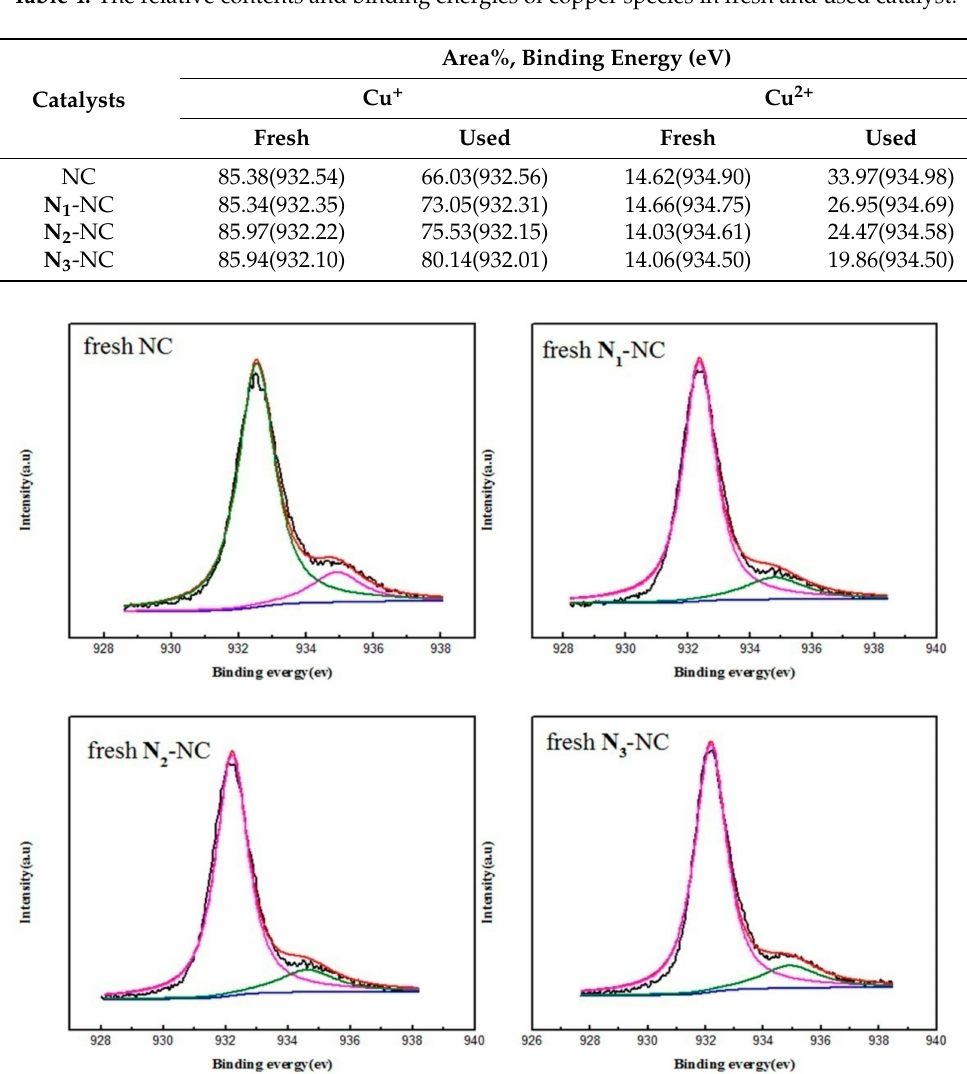
Table 4. The relative contents and binding energies of copper species in fresh and used catalyst.